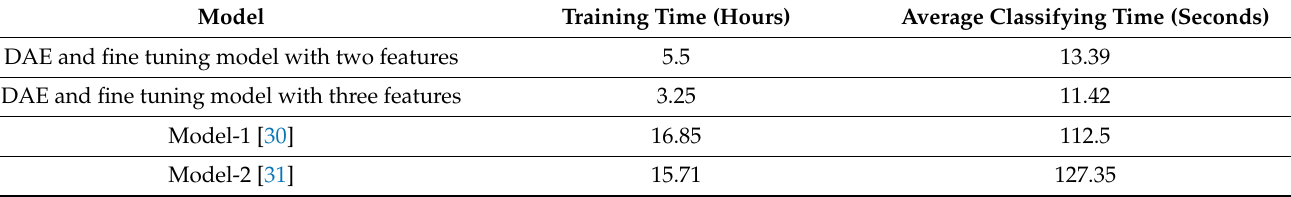
Table 15. Computation time